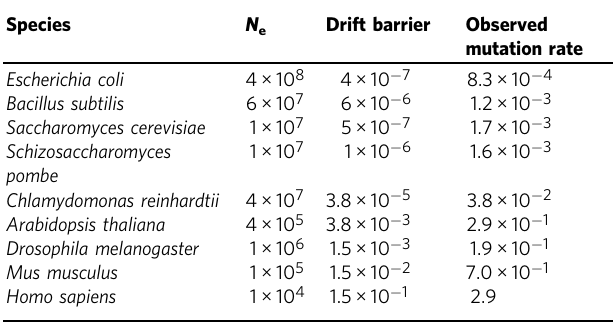
See “ Methods ” for references and drift barrier